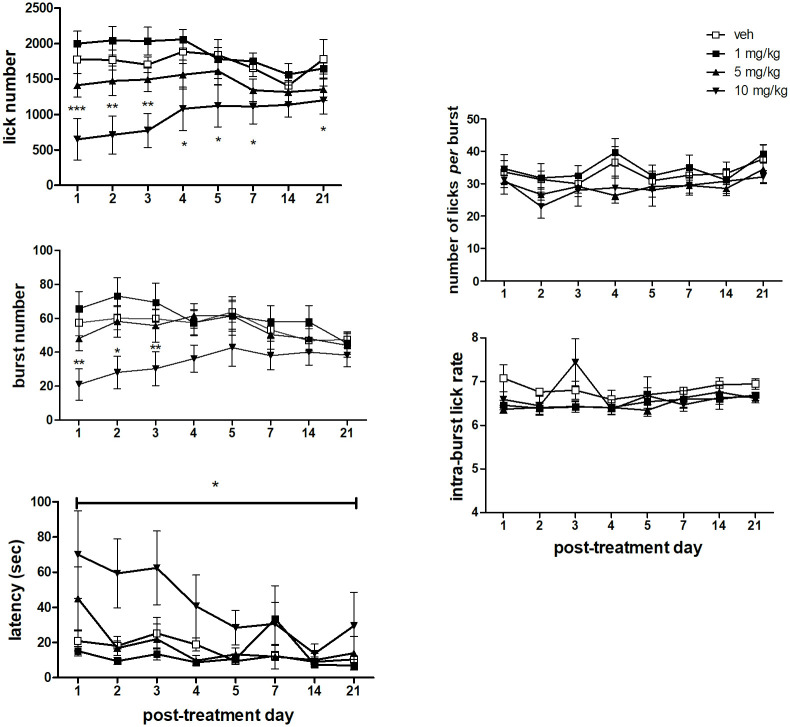
Licking microstructural parameters after discontinuation of a 13 day daily treatment with memantine.Values represent the mean ± S.E.M. from 9 subjects. Memantine 10 mg/kg versus vehicle: *P<0.05, **P<0.01, ***P<0.001 (ANOVA followed by F-test for contrasts or Newman-Keuls test; straight lines indicate comparisons involving consecutive time points).